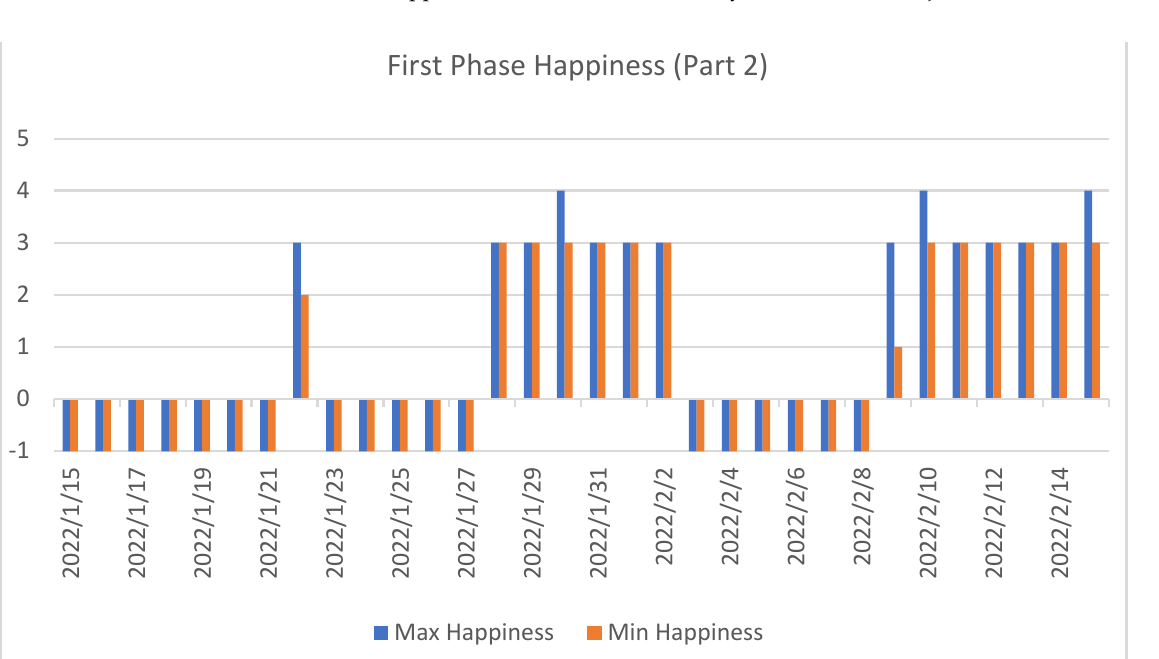
Figure 14. First set of data from the first phase of the experiment. This figure shows the maximum and minimum happiness values recorded each day for the second subject.